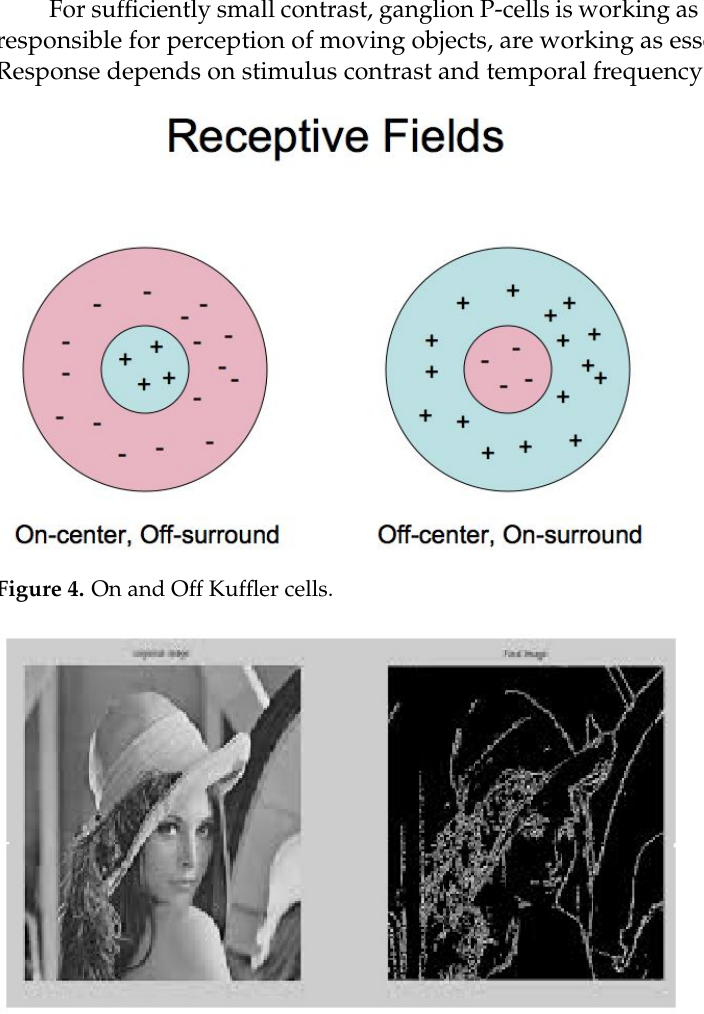
Figure 5. Action of Marr